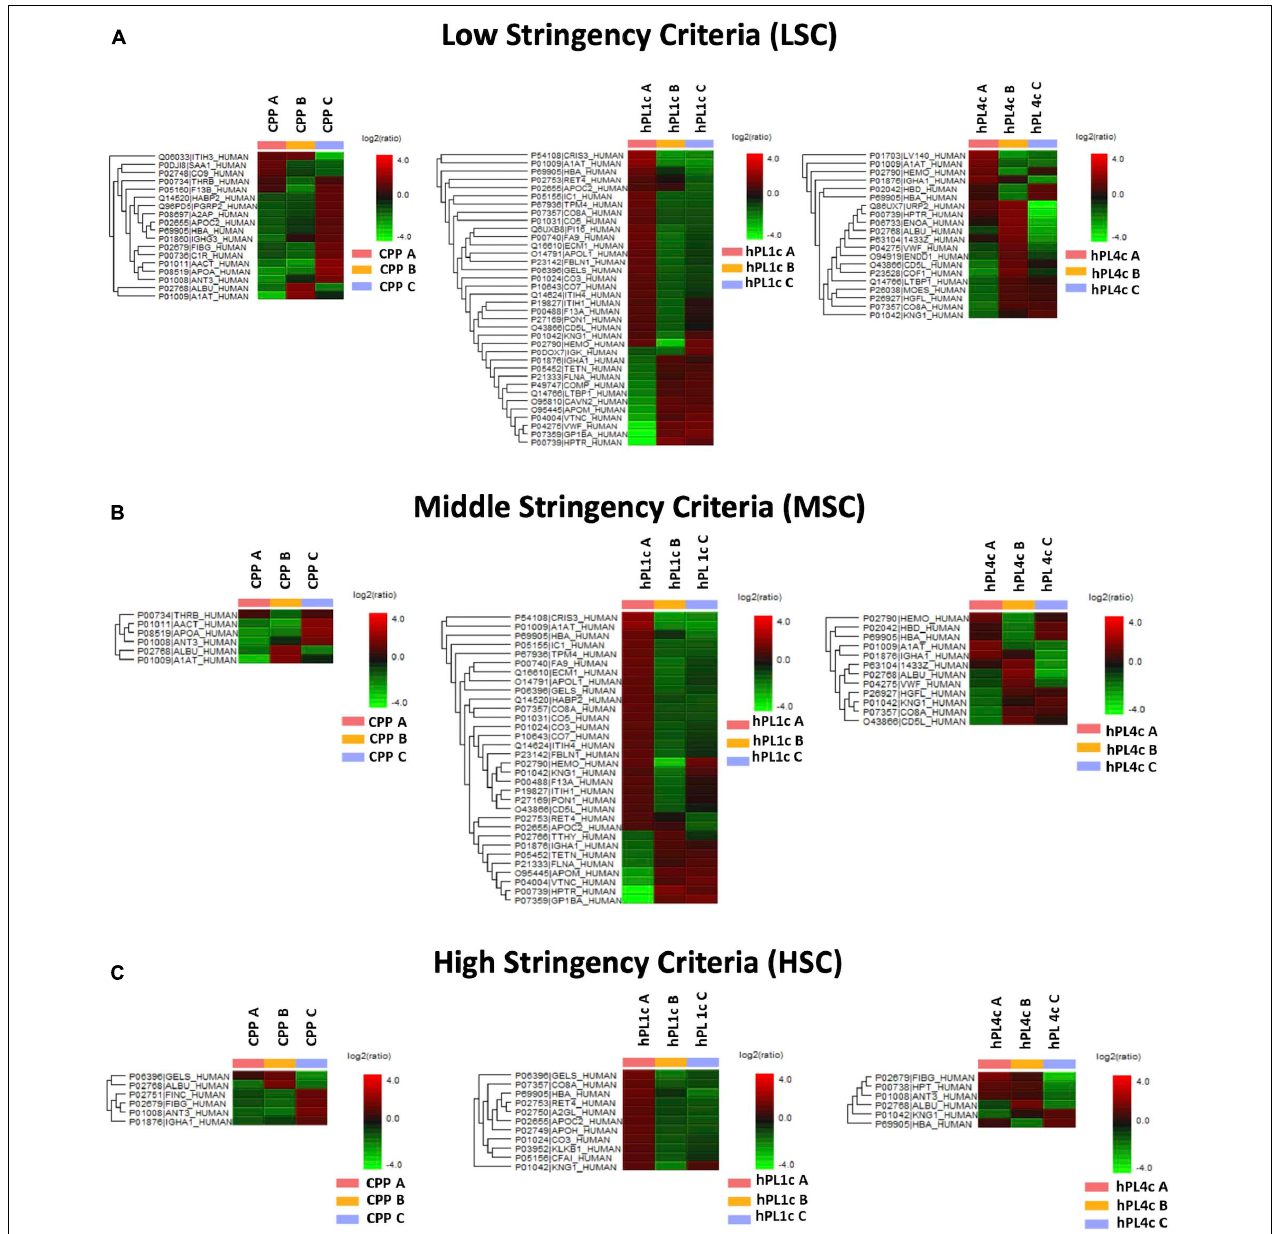
FIGURE 3 | Proteome differences for batch-to-batch variability in CPP, hPL1c, and hPL4c. Heatmaps of significant protein differences ( p < 0.05, fold change ≥ 1.5, at least two unique peptides/protein) between three different batches (A–C) for CPP, hPL1c, and hPLC4c applying three levels of stringency for peptide filtering in PEAKS Studio X+. UniProt names and the relative normalized abundance ratio of the protein differences are illustrated and plotted in the heatmaps. CPP, cryoprecipitate-poor plasma; hPL1c, human platelet lysate using one freeze/thaw cycle; hPL4c, human platelet lysate using four freeze/thaw cycles. (A) Low stringency criteria (LSC): Ave-Area ≥ 5E4, peptide ID count: 0, confidently detected sample: 0; (B) Middle stringency criteria (MSC): Ave-Area ≥ 1E5, peptide ID count: 0, confidently detected sample: 0; (C) High stringency criteria (HSC): Ave-Area ≥ 5E5, peptide ID count: 1, confidently detected sample: 1. A higher number of proteins highlights a greater variability. As shown, independently from the applied conditions, hPL1c shows a wider variability compared with hPL4c and with its starting point